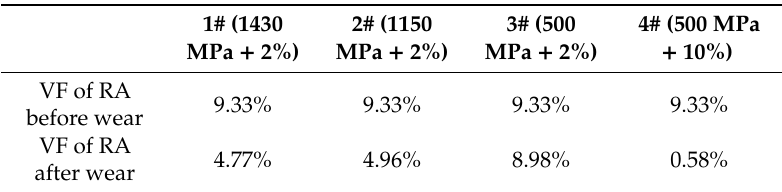
Figure 10. Comparison of XRD spectrums obtained from the worn surface with four kinds of wear conditions. Table 6. Volume fraction of RA in bainitic rail steels with four kinds of wear conditions (about 1.0% deviation value in retained austenite